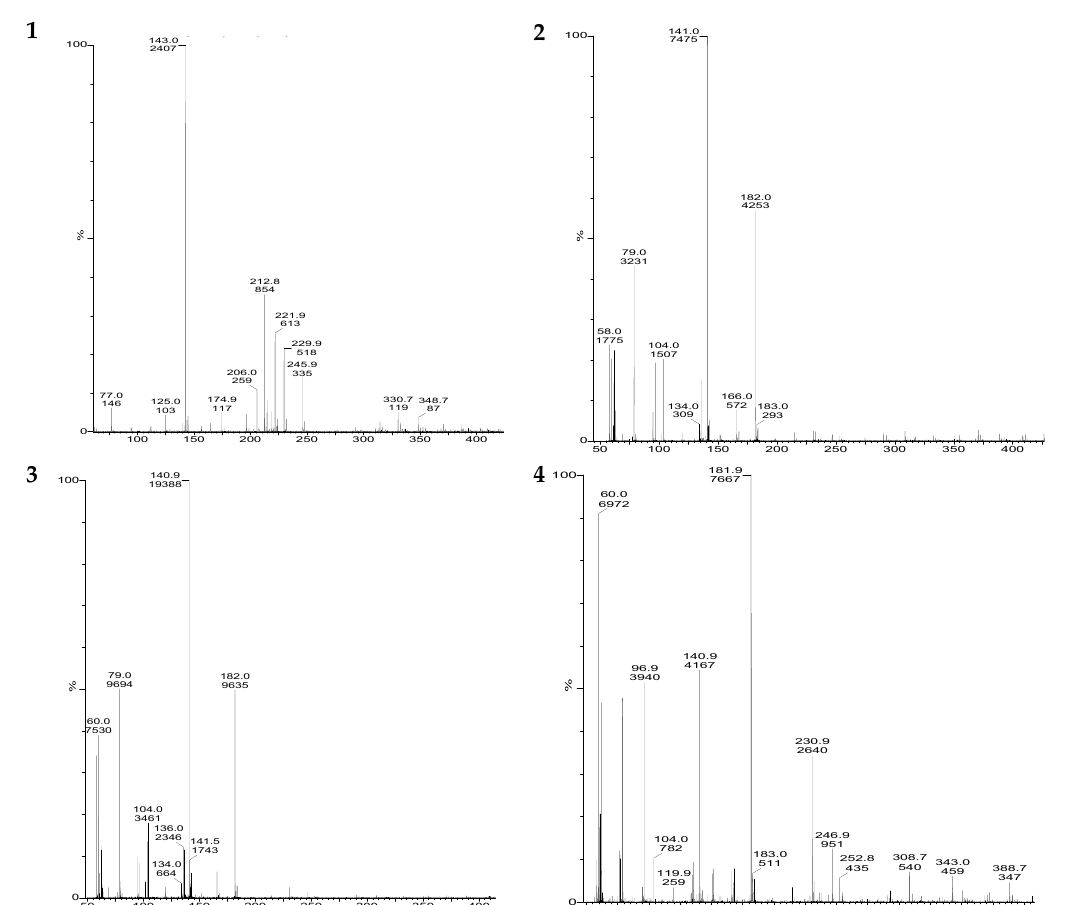
Figure 4. LC-MS(Liquid Chromatography–Mass Spectrometry) chromatogram (after 30th day) of ( 1 ) acephate + strain, ( 2 ) acephate + strain + Cu(II), ( 3 ) acephate + strain + Fe(III), and ( 4 ) acephate + strain + humic acid (here strain is P. aeruginosa ).